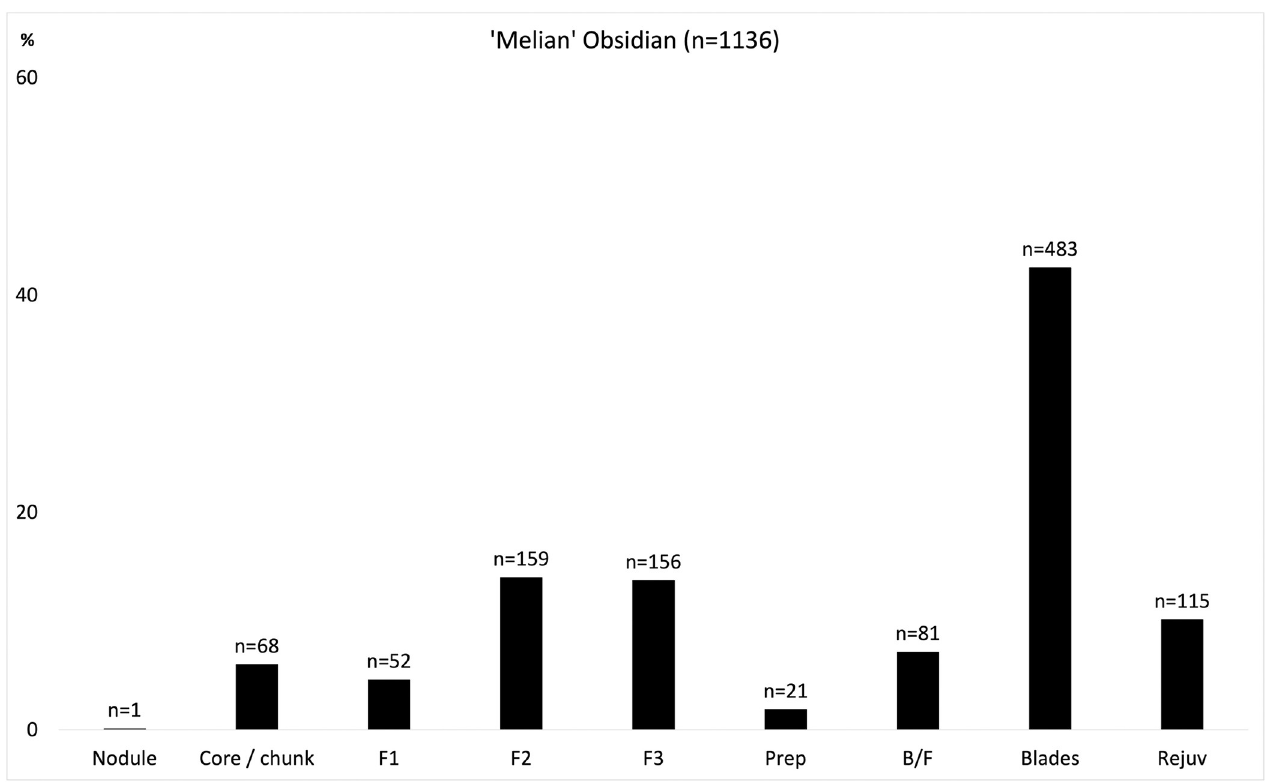
Fig 6. Techno-typological classes represented in the Quartier Nu ‘Melian’ obsidian assemblage, as defined by visual discrimination. F1 / F2 / F3 = > 80% / 5–80% / < 5% cortex on dorsal surface, respectively; Prep = core preparation flake; B/F = blade-like flake; Rejuv = core rejuvenation flake. Original copyright with the